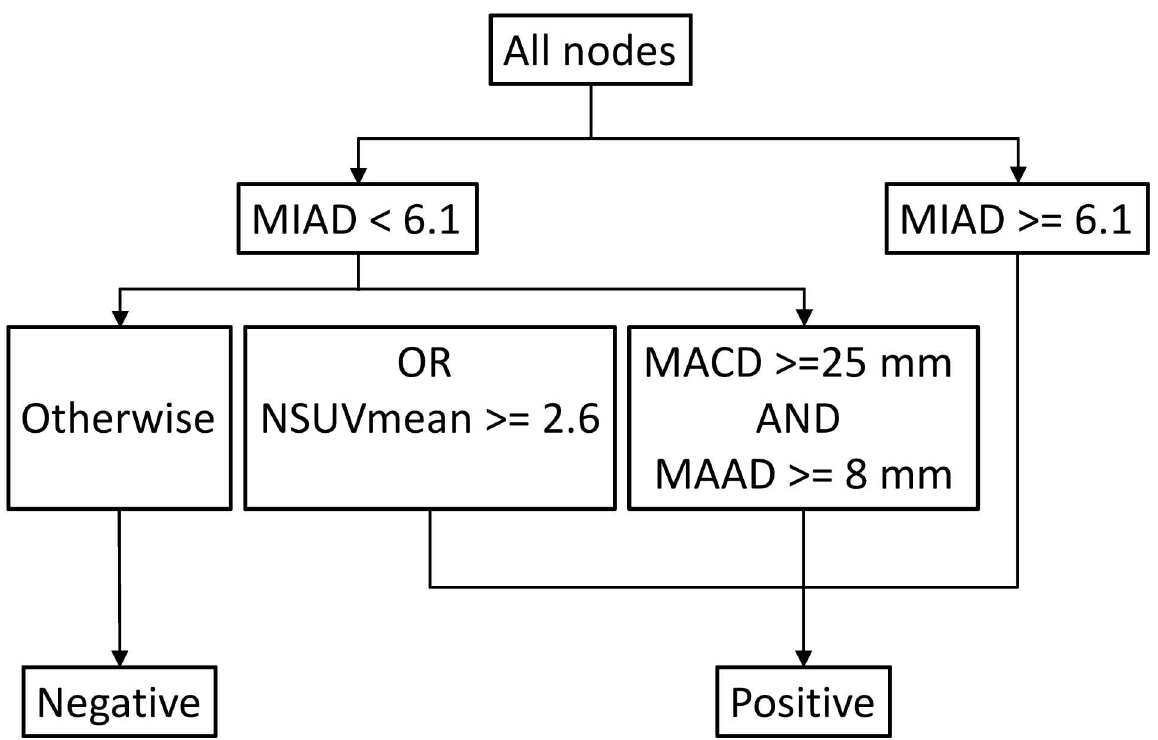
Fig 8. Stage II optimal approach. The proposedapproachdeterminedthrough brute force attack: The combination of the MIAD, MAAD, MACD, and NSUV prevented the false positive diagnosisof as many as 6 in 45 nodes (13.3%). MIAD, minimal axial diameter; MAAD, maximal axial diameter; MACD, maximal coronaldiameter; NSUVmean, mean standard uptake